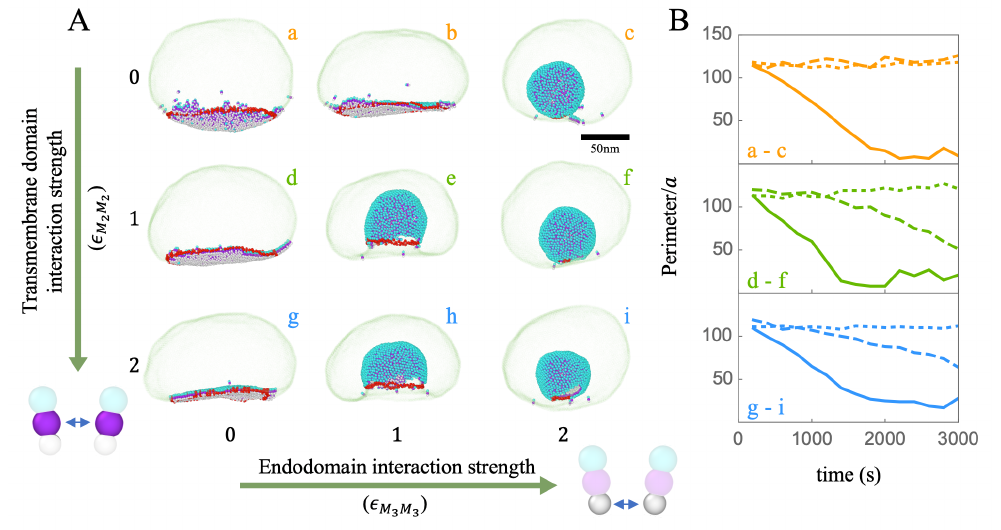
Figure 6. ( A ) Snapshots of budding through the ERGIC membrane as a function of the strength of the interaction between the M protein transmembrane domains ( y -axis) and between the endodomains ( x -axis). The interactions become stronger from top to bottom and from left to right. The lipid–lipid interaction strength is kept constant (cid:101) McMc = 1 for all simulations; ( B ) the perimeters (in the unit of a